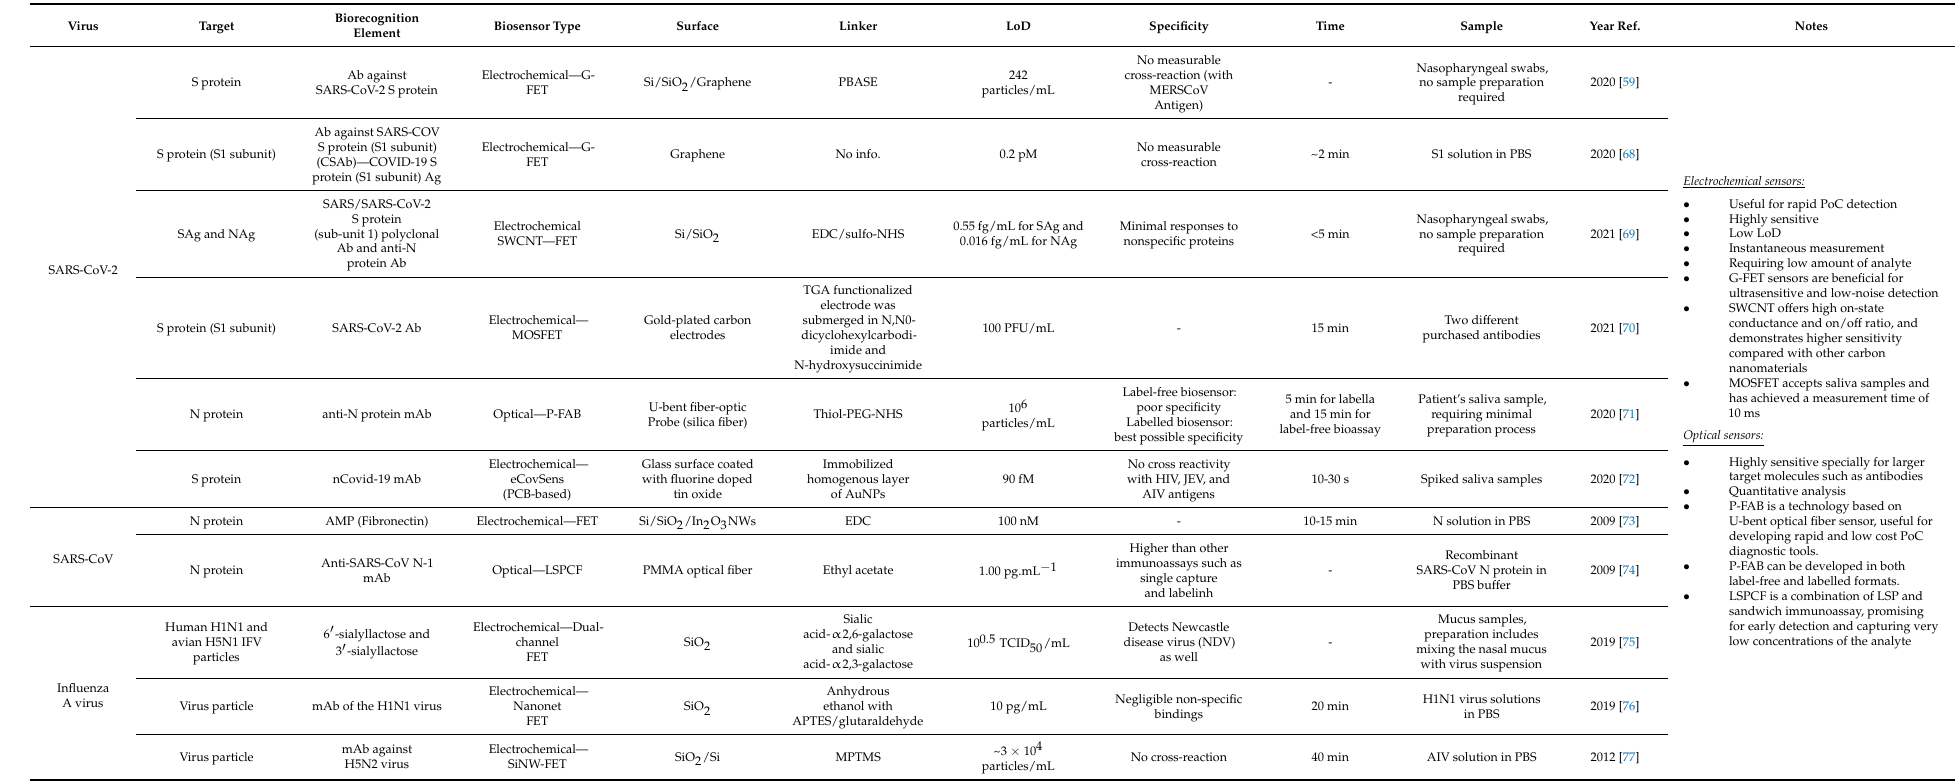
Table 2. The recent immunosensors functionalized with antibodies for the detection of respiratory viral